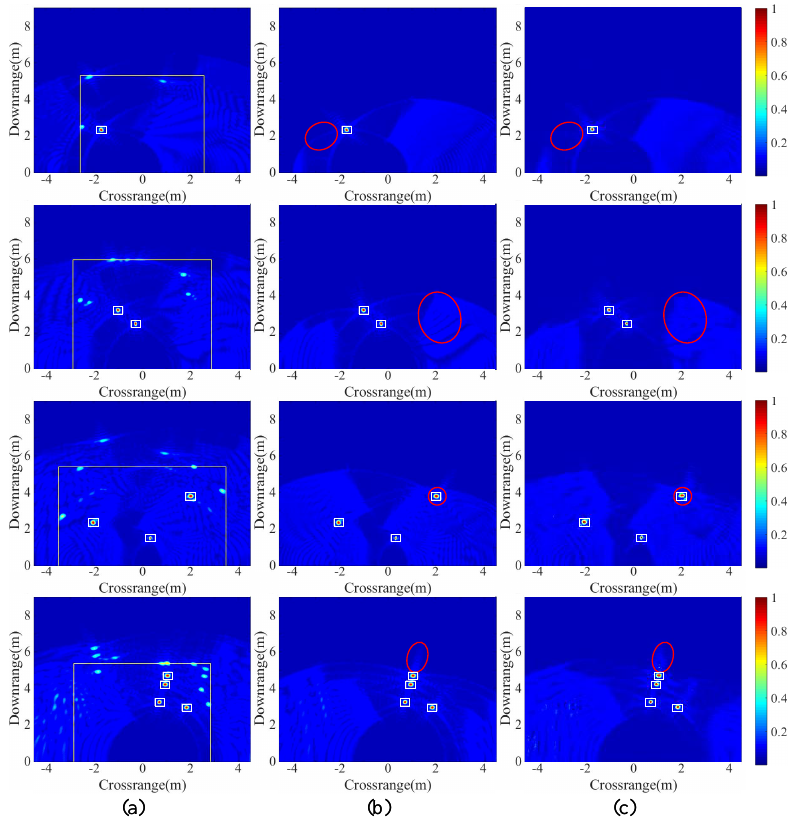
Figure 7. The results of Dataset 1. ( a ) Input images. ( b ) Ground-truth images. ( c ) Output images. The red ellipses mark the differences between the output images and the ground-truth images. The yellow lines mark the walls’ locations. The white rectangles mark the targets’